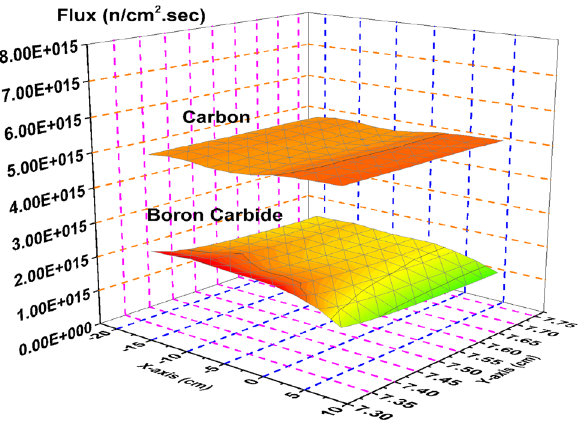
Figure 11. Epithermal flux distribution in the carbon and boron carbide control blades.